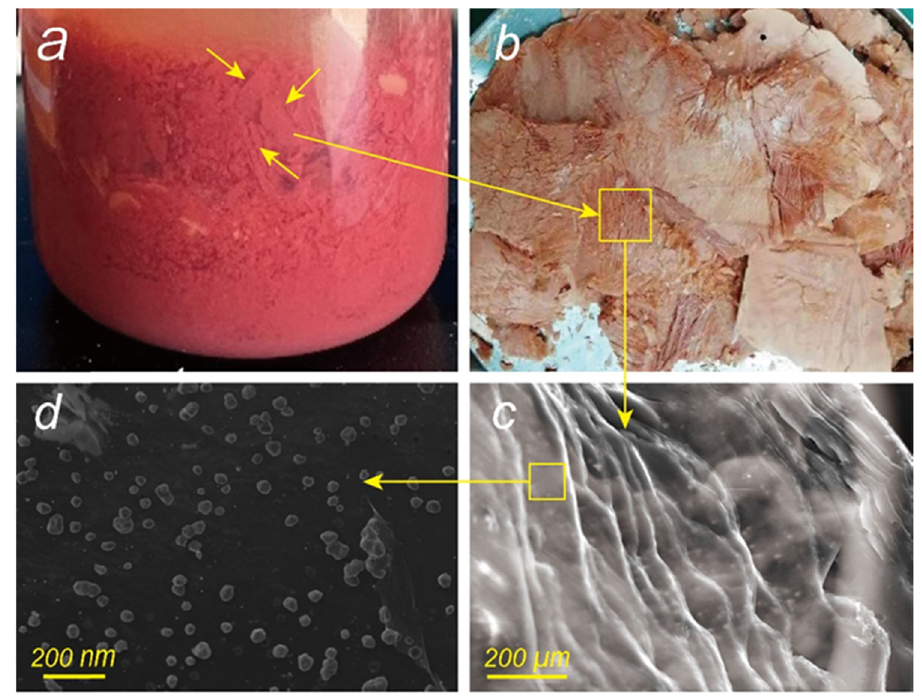
Figure 2: Digital and electron microscopy images of the synthesized sample: ( a ) digital pictures after freeze - thawing, ( b ) digital pictures of samples after freeze - drying and ( c and d ) electron microscopic images after freeze - drying.